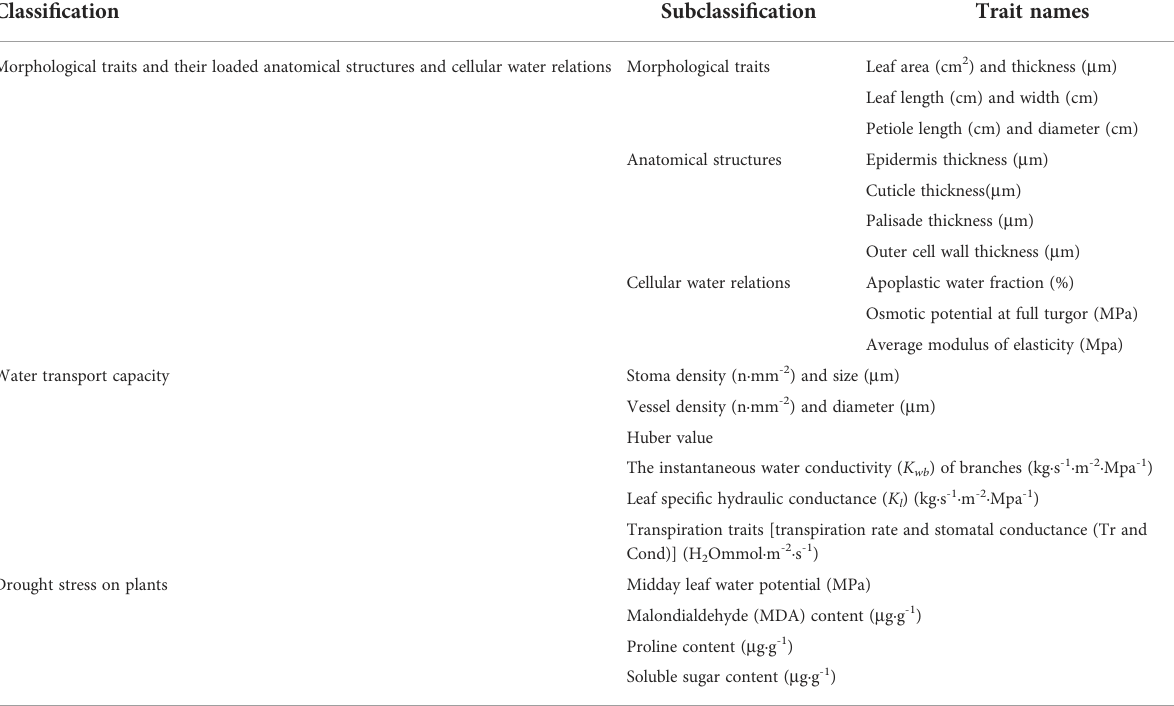
TABLE 2 The main traits used to test the hypothesis in this